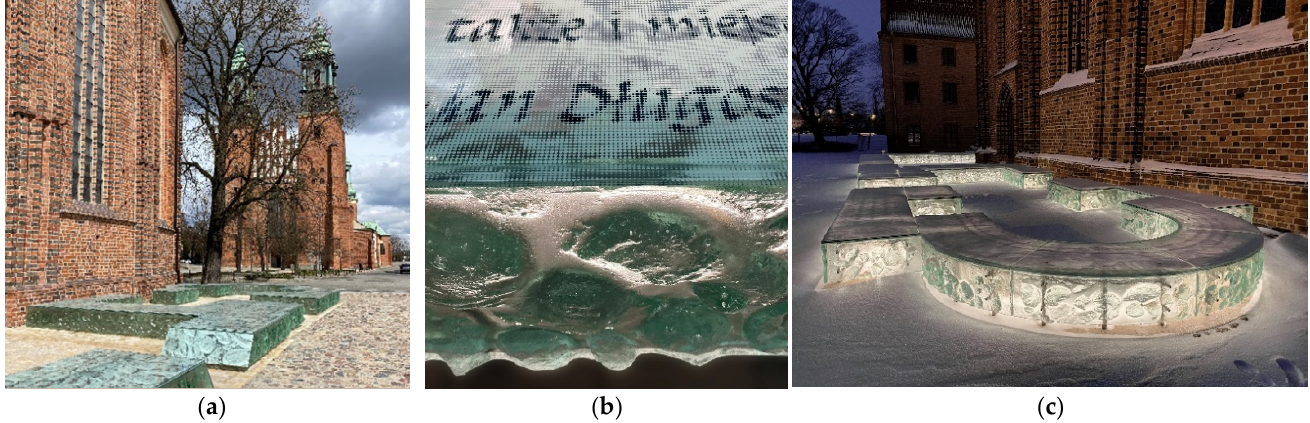
Figure 14. ( a ) The visual relationship of the color of the cathedral’s patinated copper spires and the architectural glass art composition; ( b ) details of the horizontal and vertical glass representing the play of colors and shades of green; ( c ) illumination of the installation after dusk in the historic setting (Konrad Urbanowicz).